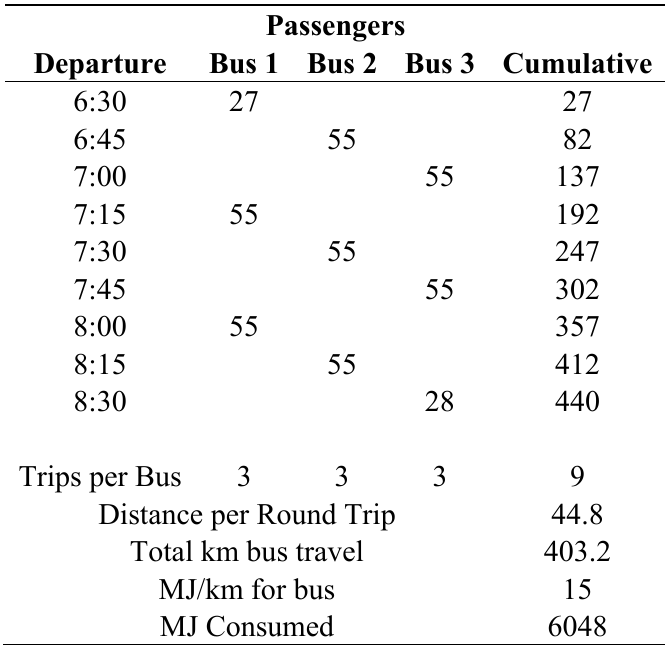
Table 2. Bus Schedule for 440